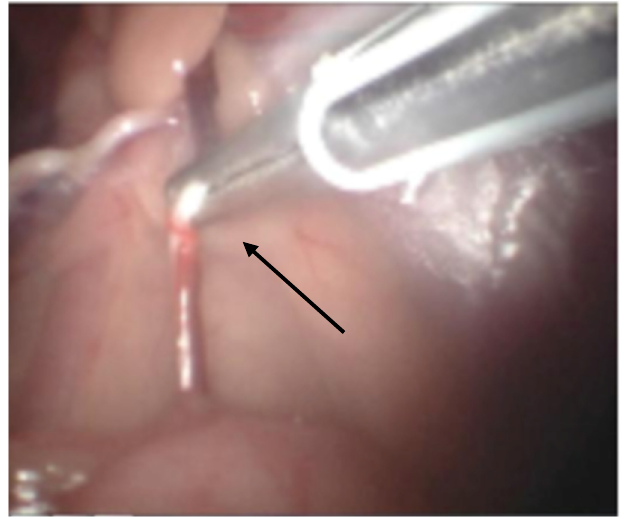
Figure 2. Coagulation of artery and vein with the high-frequency bipolar forceps with integrated scissors (arrow).